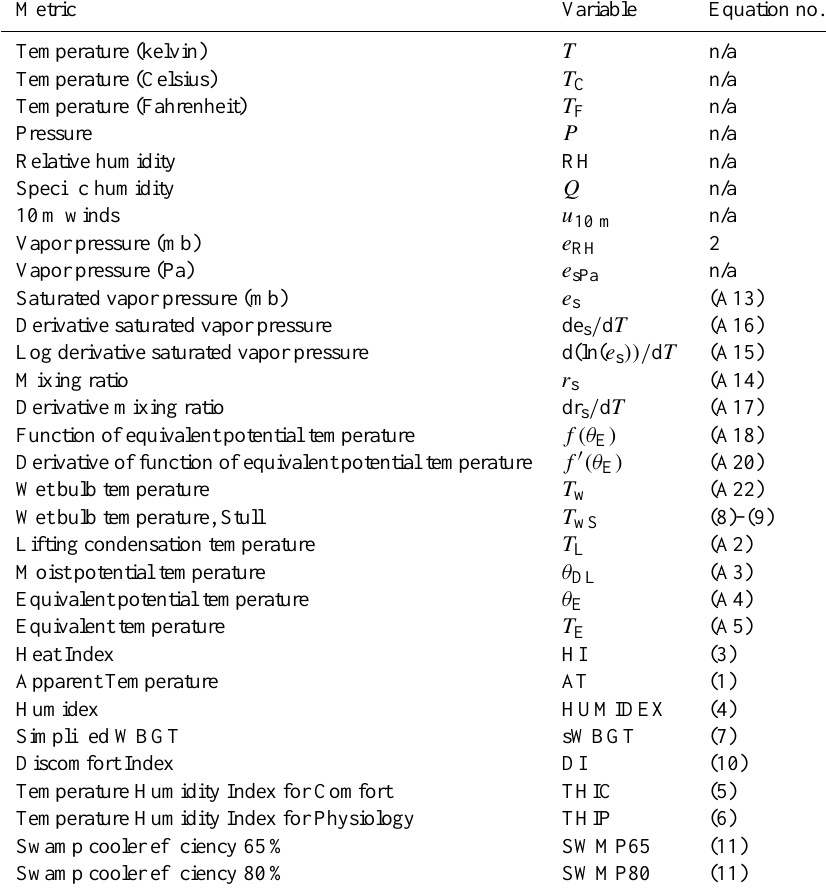
Table 2. Moist temperature variables and heat stress metrics. Metric Variable Equation